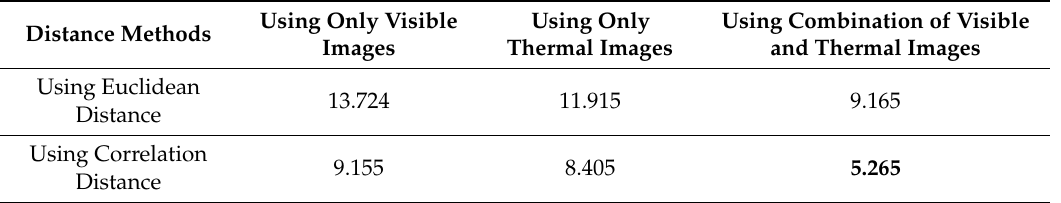
Figure 20. Flowchart of gender recognition using the combination of different body parts. Table 9. Verification performance (EERs) of the system that combines features from different parts of human body for recognition (unit: %).